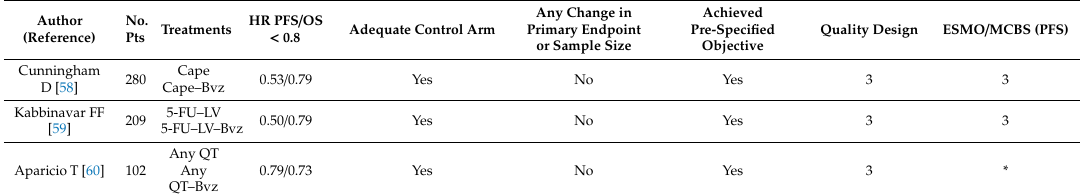
Table 2. Randomized phase II–III trials with bevacizumab in metastatic colorectal cancer in elderly